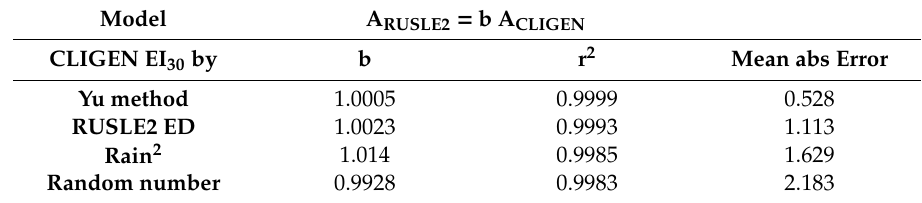
Figure 12. Relationships between at EI 30 and rain > 12.5 mm generated by CLIGEN at Watkinsville using ( A ) the Yu method and ( B ) random numbers, and ( C ) the monthly erosivity densities generated from those EI 30 values and when EI 30 is related to the square of rainfall amount. (source: Kinnell and Yu (under review) [57]). Table 4. Regression analysis for the relationships between average annual soil loss predicted by RUSLE2 operating in its standard mode (A RUSLE ) and average annual soil loss predicted by CLIGEN (A CLIGEN ) when R d values are generated by different methods at the seven locations.